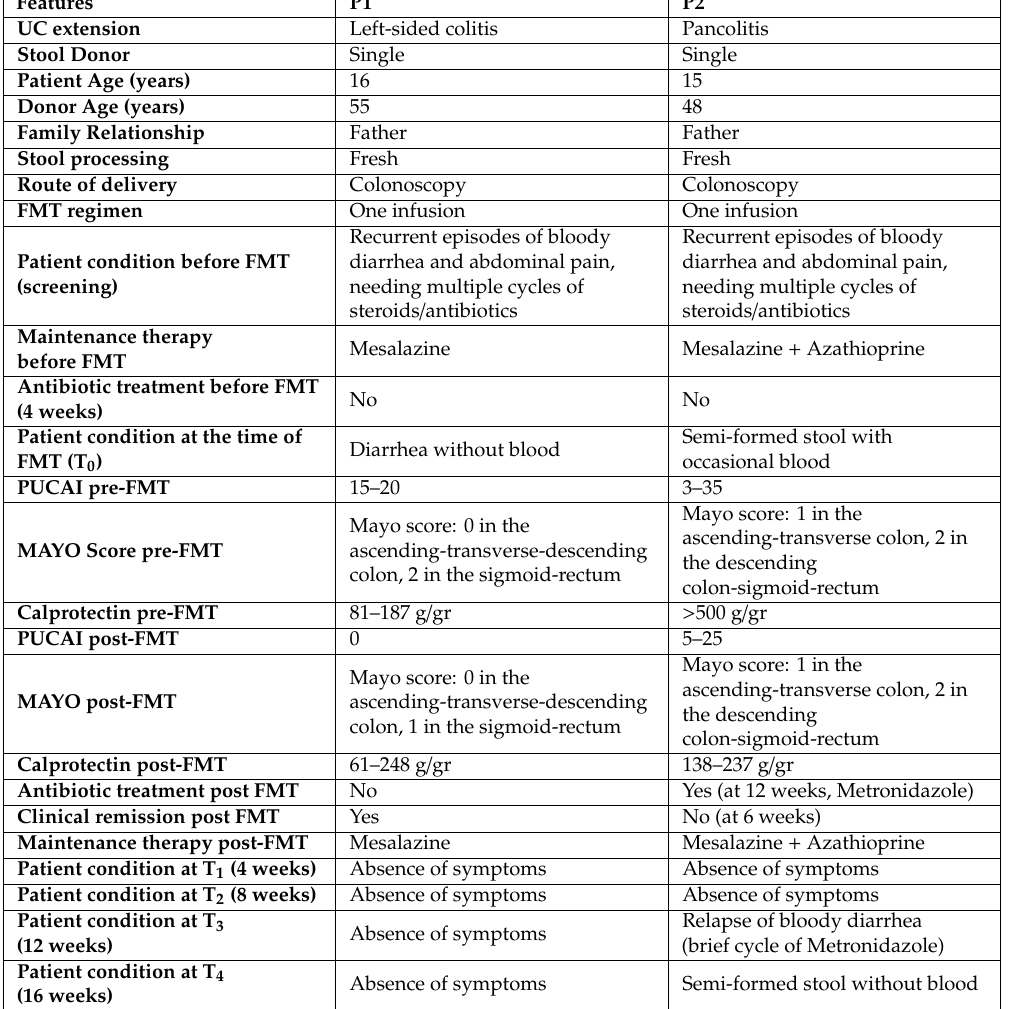
Table 1. Clinical features of P1 and P2 patients. Calprotectin and PUCAI pre-FMT ranges refer to measurement performed in the three months before transplantation, while Calprotectin and PUCAI post-FMT values refer to T 0 –T 4 time